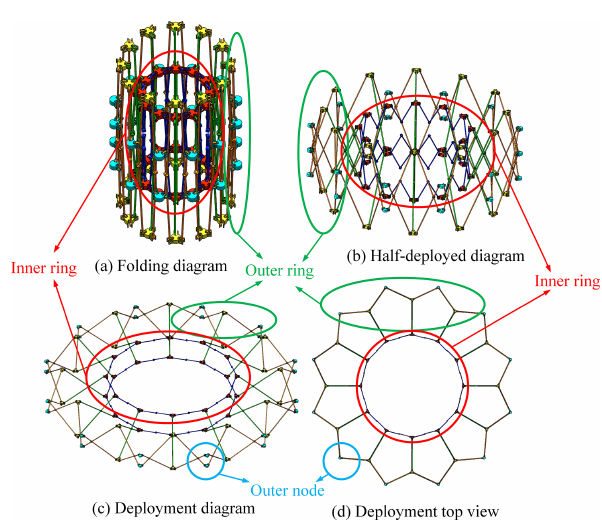
Figure 2. Scissor-type multi-rod